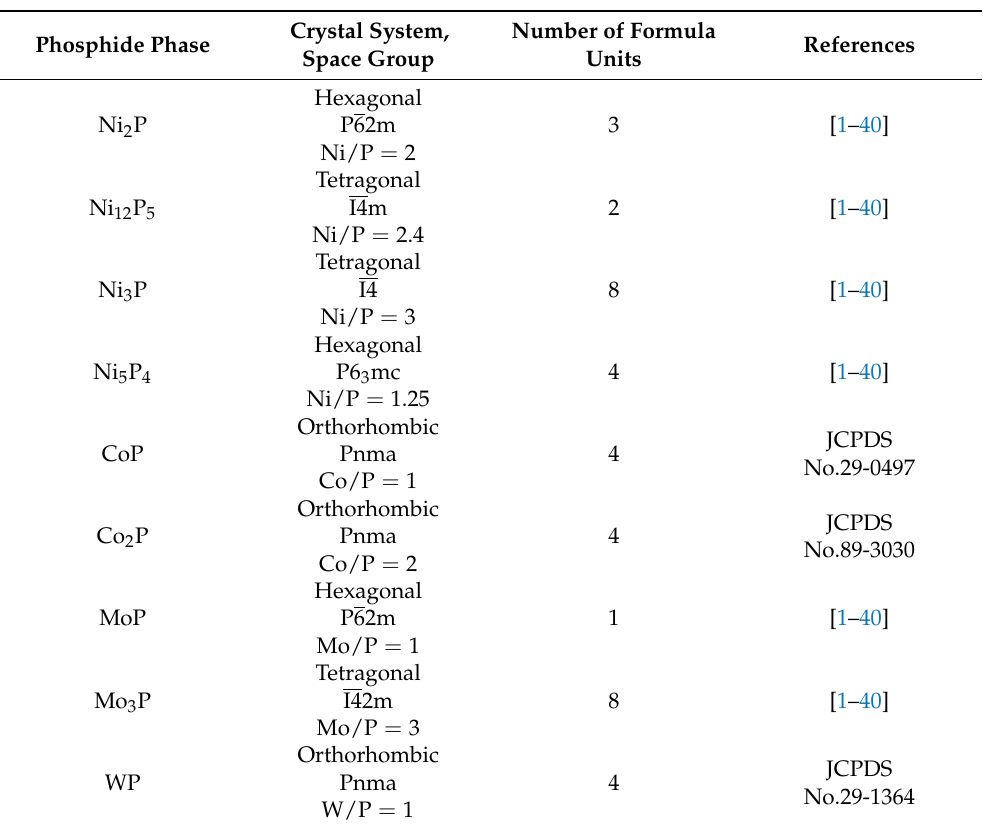
Table 3. Different TMPs and their crystalline